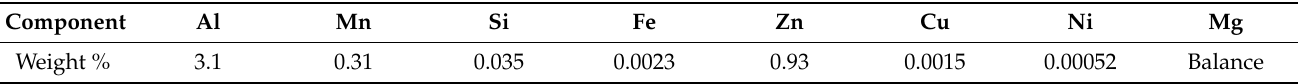
Table 1. Chemical compositions of magnesium alloy AZ31 sheets taken for this